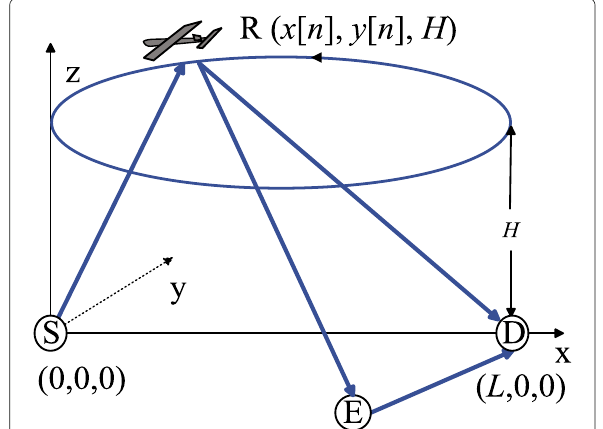
Fig. 1 System model of proactive eavesdropping in a UAV-aided suspicious relay